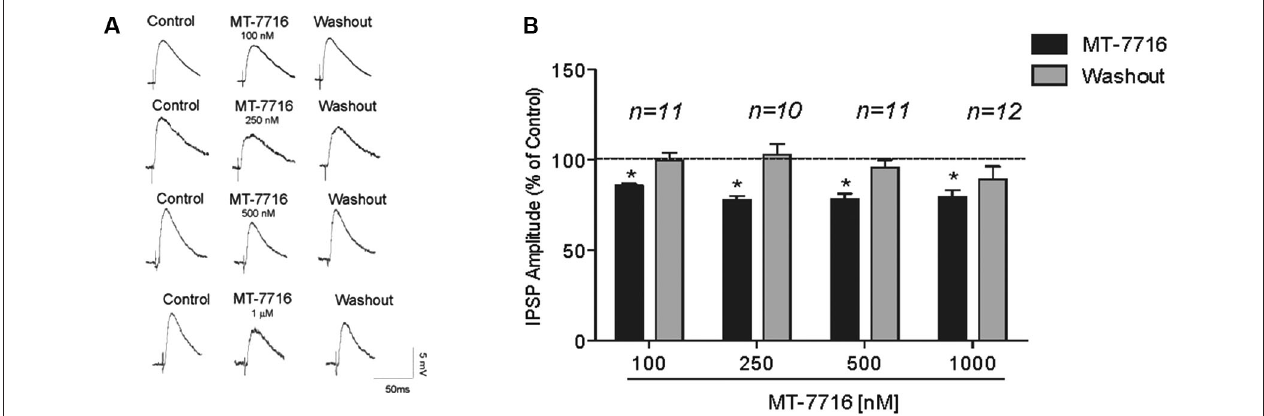
max stimulus intensity) IPSP amplitudes during superfusion of different concentrations (100, 250, 500, and 1000 nM) of MT-7716 and washout. Overall ANOVA revealed that MT-7716 decreased statistically significantly the IPSP amplitudes. Post hoc Newman-Keuls showed significant effect for all the doses at half max stimulus intensity. (*) Indicates p < 0.01.